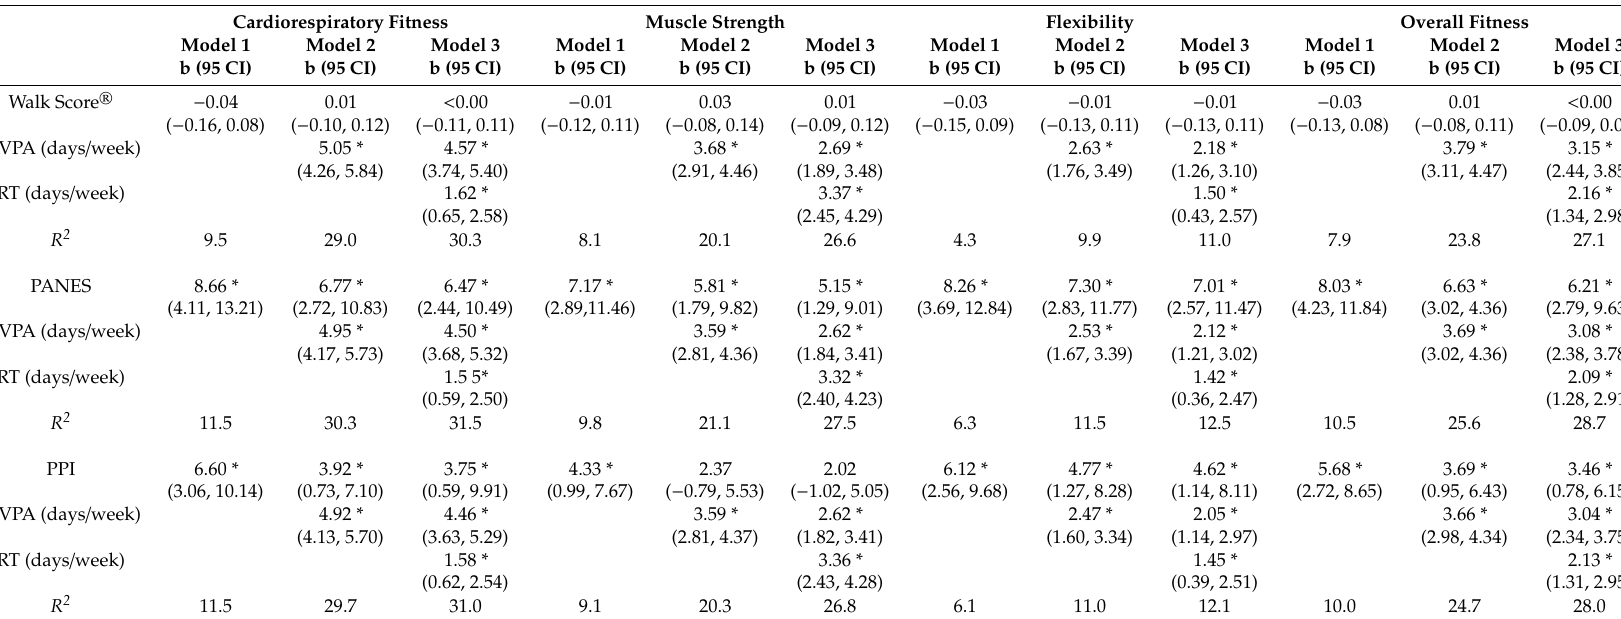
Table 2. Linear regression unstandardized coe ffi cients (b) and 95% confidence intervals (95 CI) for the association between perceived fitness, built environment, and physical activity ( n =